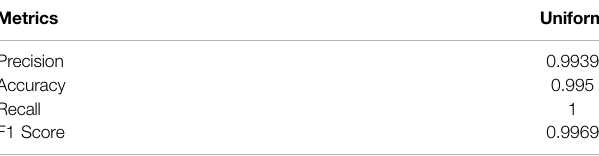
TABLE 6 | Summary of the metrics for 300 with a ratio of 2 between 3D and 6D load cases for Trained ML yield function. Metrics